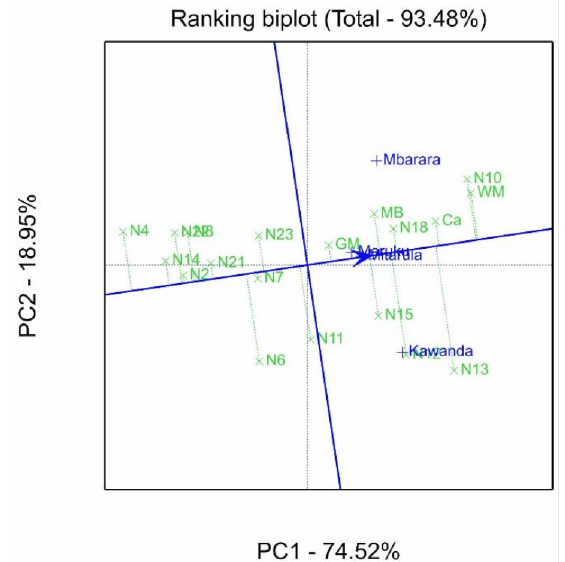
Figure 3. The “mean vs. stability” view of the GGE biplot showing the ranking of 19 banana genotypes (Matooke hybrids N—NARITA and banana varieties; MB—Mbwazirume, WM—Williams, Ca—Cachaco, GM—Gros Michel) evaluated in four locations for response to black Sigatoka (AUDPC) in 2016 to 2018. The 10 hybrids on the left side of the biplot developed the least disease, and those on the right-hand side the most disease. The most stable genotypes are those with a short projection on either side on the average environment axis (line with an arrow passing through the biplot